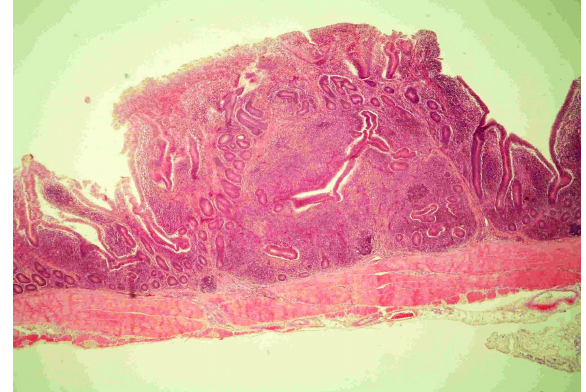
Fig. 10 . Broiler chicken’s caecal tonsil, the 1 st group. thec30 th day. H&E. x